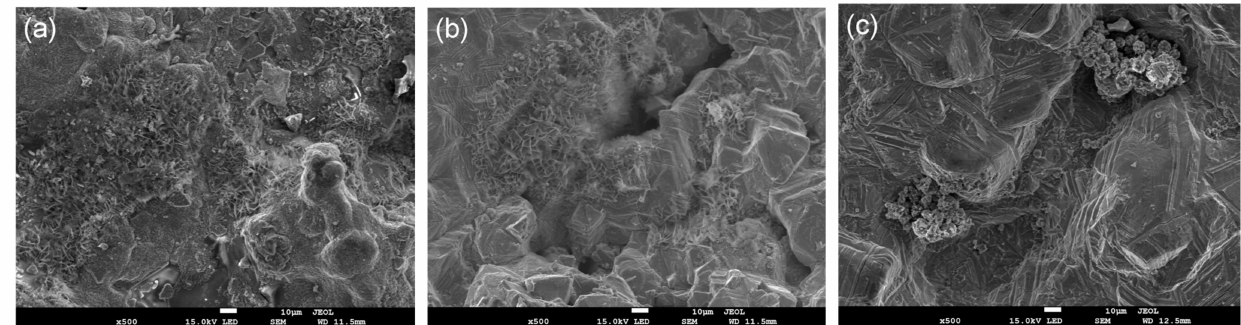
Figure 5. SEM micrographs of the three composite pellets with different reducing agents after being reduced at 1100 ◦ C for 60 min: ( a ) biomass, ( b ) charcoal, ( c )